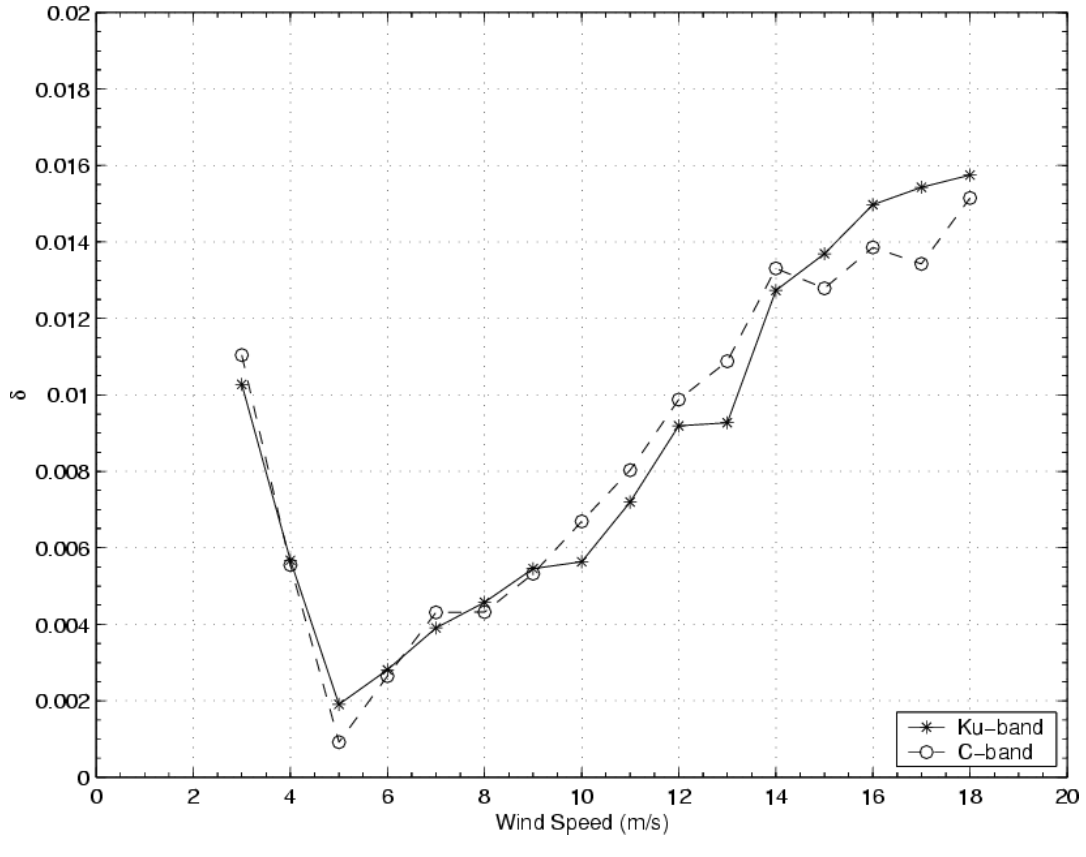
Figure 3 . Depth of azimuthal modulation δ at Ku- and C-band as a function of wind